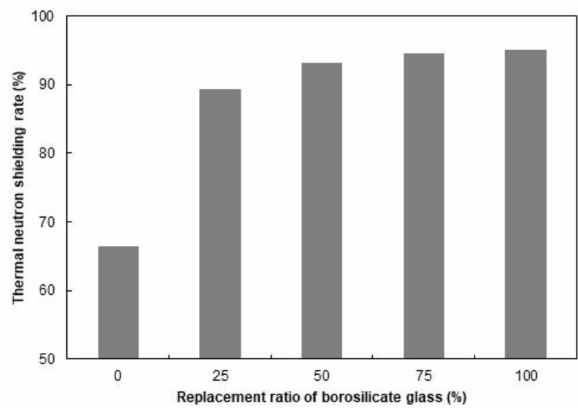
Figure 7. Thermal neutron shielding performance of cement mortar with borosilicate